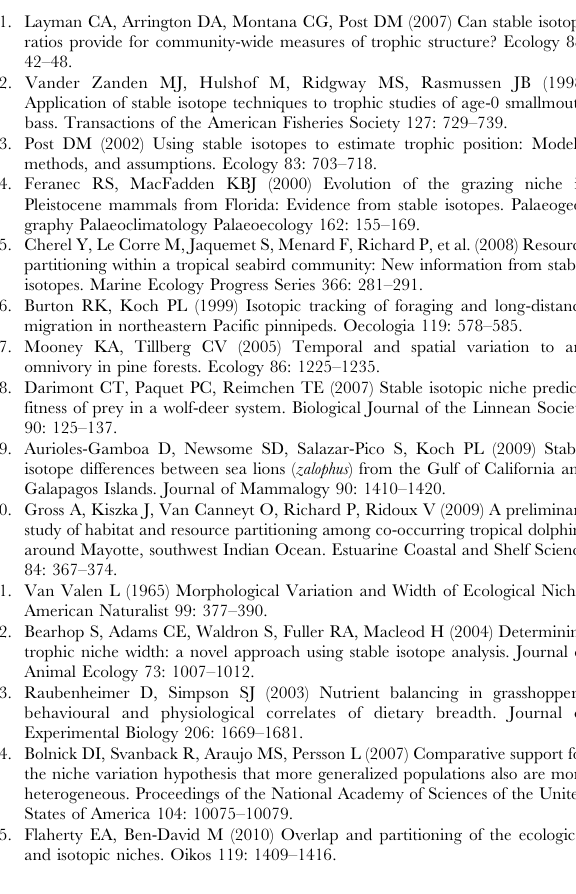
Figure S3 Data output from simulations of the isotopic signatures from the modelled Almaco Jack in d -space. A) Habitat generalists specialising on the common species (D s H g ) accounting for distance between sites – Part 2. B) – Habitat specialists feeding on the entire prey assemblages (D g H s ) – Part 3. (TIF) Text S1 Detailed model description.